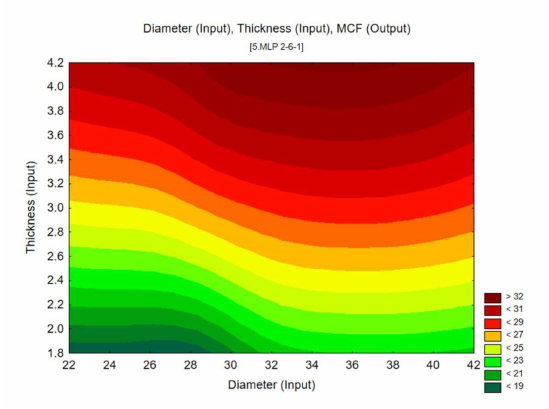
Figure 19. Mean crushing force (MCF) predicted by MLP 2-6-1 artificial neural network.